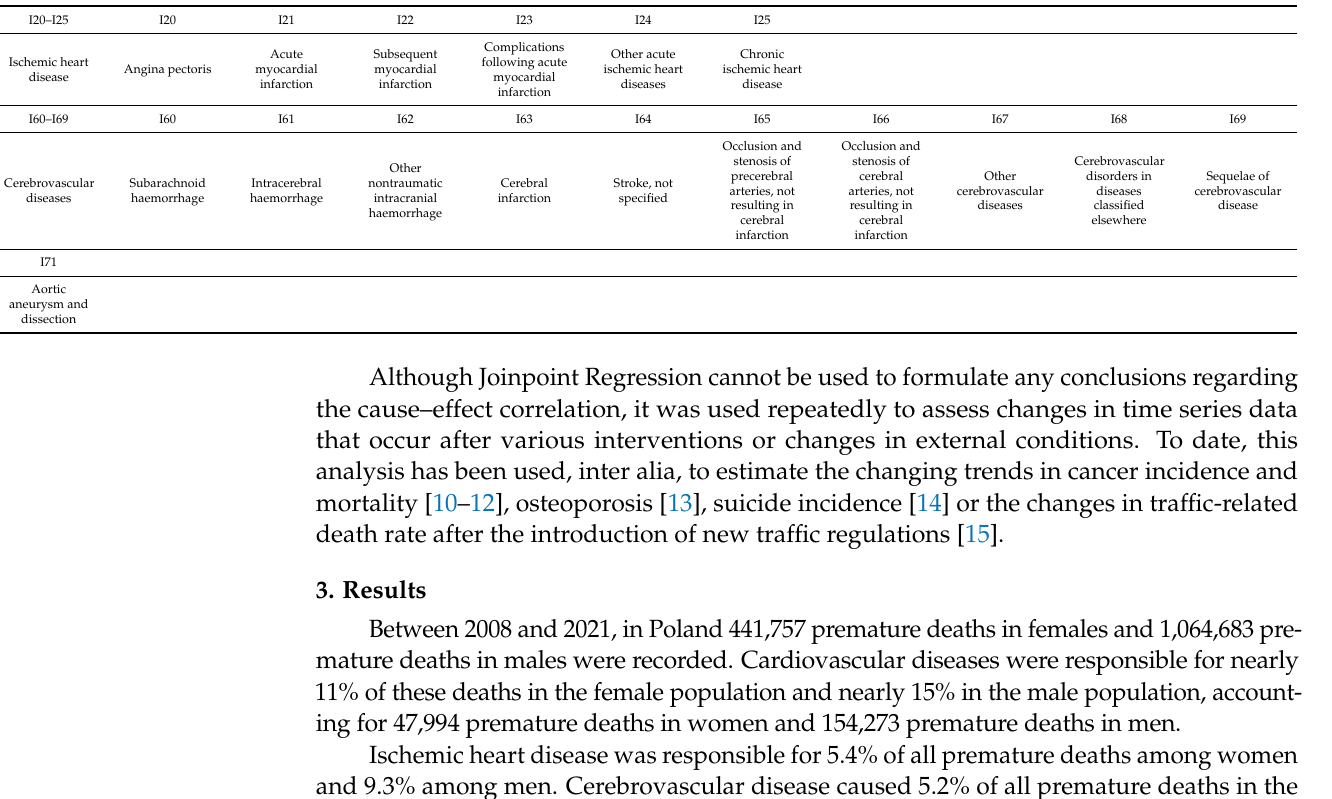
Table 1. The analyzed groups and cardiovascular diseases.